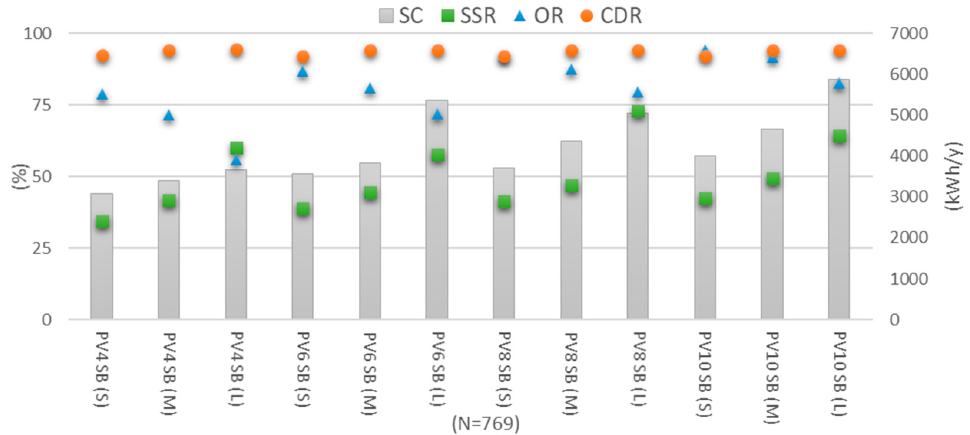
Figure 7. Annual self-sufficiency rate, operation rate, and charge and discharge rate for PV and SB. The SSR was the highest for PV8SB (L) at 73%, followed by PV10SB (L) at 64%. The operation rate (OR) decreased as the SB capacity increased. In comparison, for a given SB capacity, the OR improved with the PV capacity. The charge–discharge efficiency was 85–94% but tended to increase with the capacity, because the larger the proportion of hybrid power conditioners (integrated power conditioners of PV and SB), the larger is the loss.